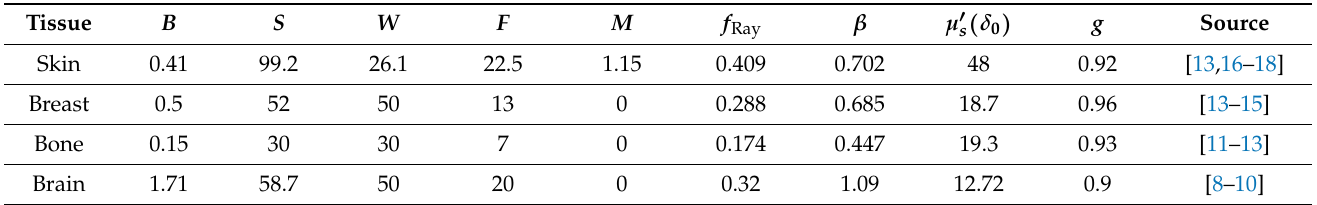
Table 3. Tissue parameters related to optical absorption and scattering for skin, bone, brain, and breast